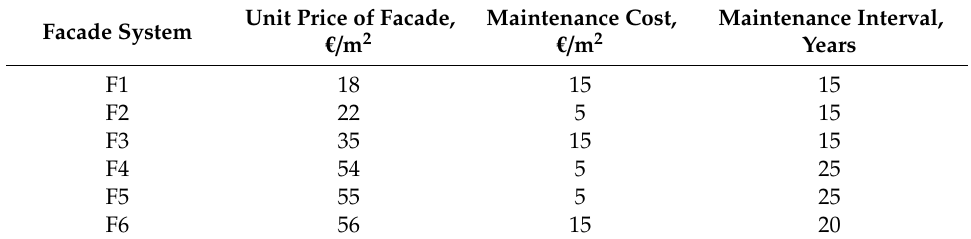
Table 10. Unit prices, maintenance cost and intervals of maintenance of facade systems of the prefabricated elements. See Table 1 for description of layers